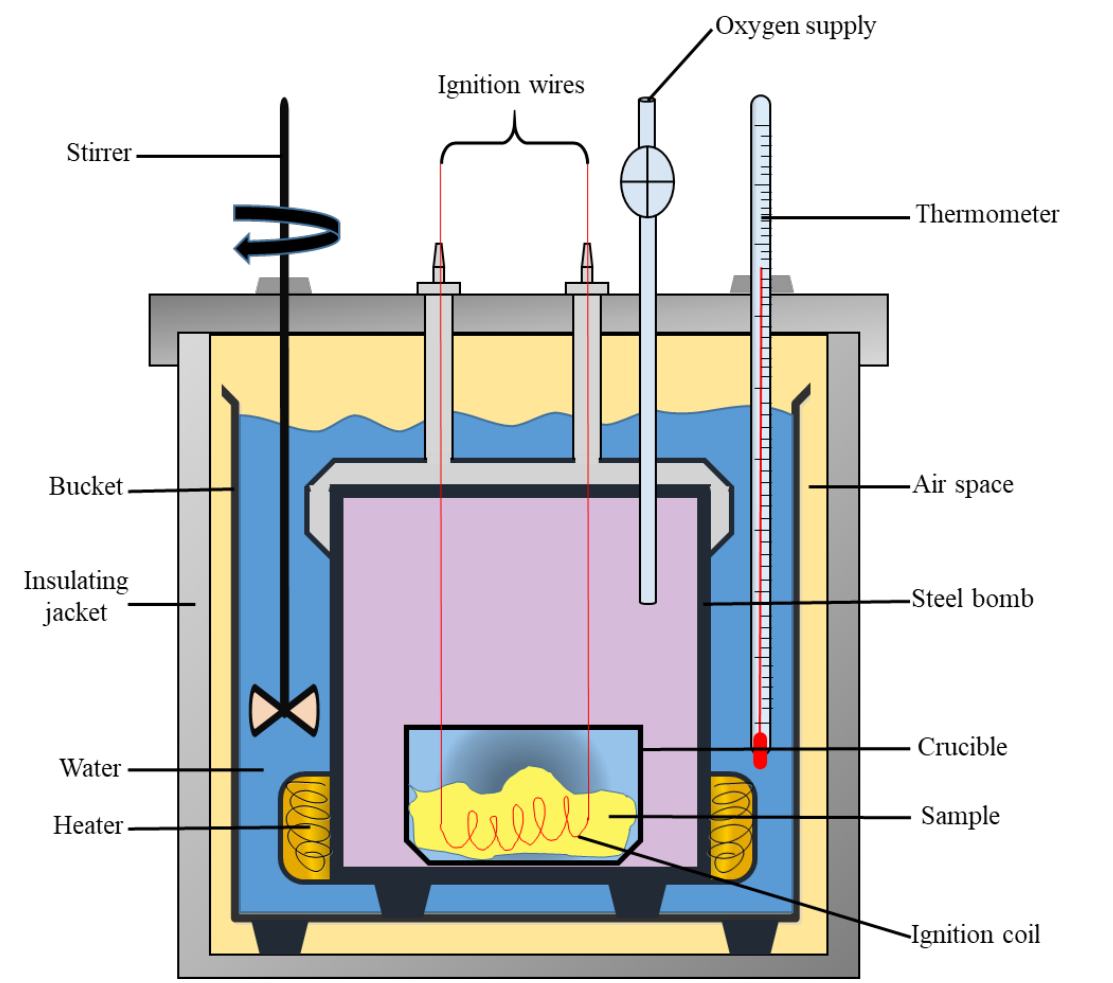
Figure 1. A cross-sectional view of typical bomb calorimeter .